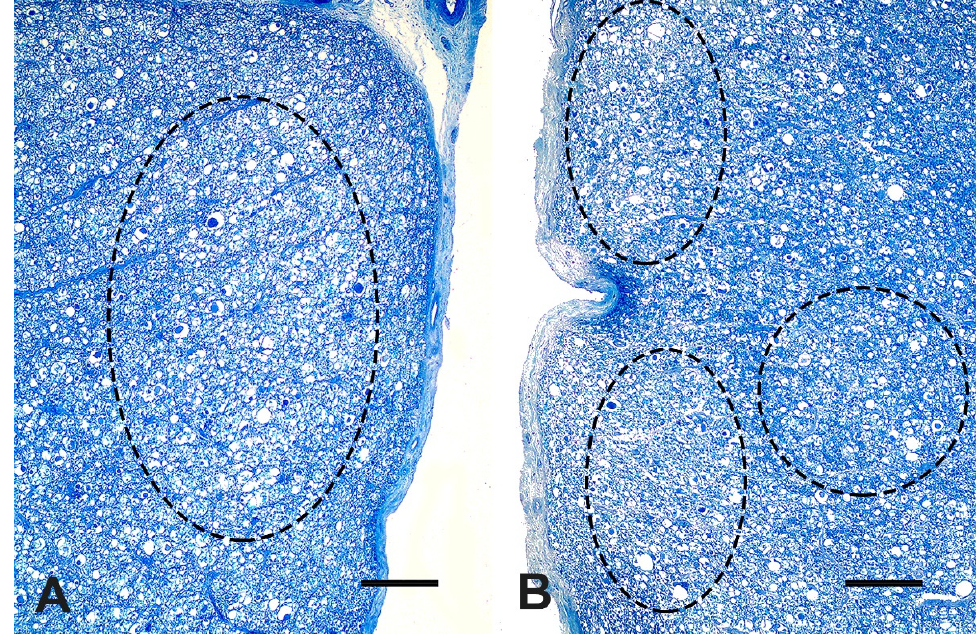
Figure 4. White matter of C3–C4 segment of the spinal cord of a four-month-old Nelore calf. ( A ) Left dorsal funicle, sensitive ascending bundles. Dilated myelin sheaths and multifocal axonal spheroids (Luxol fast blue-cresyl violet stain—LFB, bar = 250 μ m). ( B ) Left lateral funicle, sensitive ascending bundles (ellipses), and motor descending bundles (circle). Wallerian degeneration and numerous axonal spheroids (LFB, bar = 250 μ m).